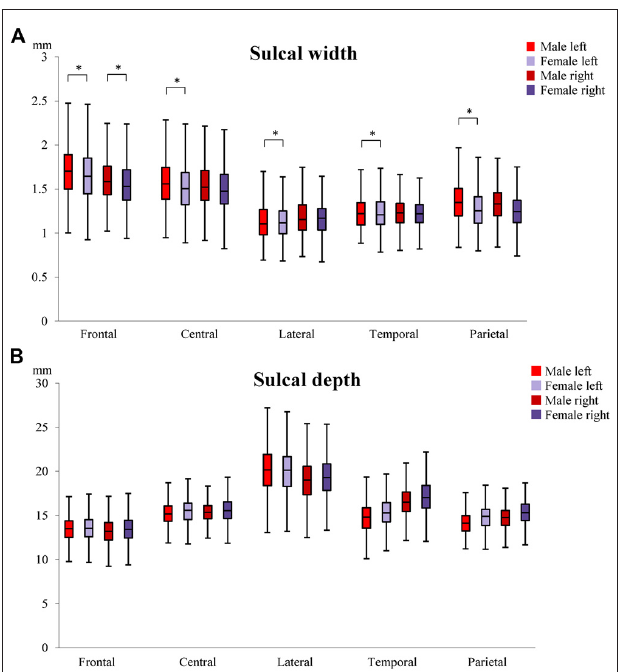
FIGURE 3 | Differences in sulcal width (A) and depth (B) between middle-age (MA) and old-age (OA). The median, 1st and 3rd quartile range of sulcal widths and depths in MA and OA are shown. Whiskers show minimum and maximum value. ∗ Indicates significant ( p < 0.01) age group differences in sulcal width/depth. Superior frontal sulcus (frontal); central sulcus (central), lateral sulcus (lateral); superior temporal sulcus (temporal); intra-parietal sulcus (parietal).